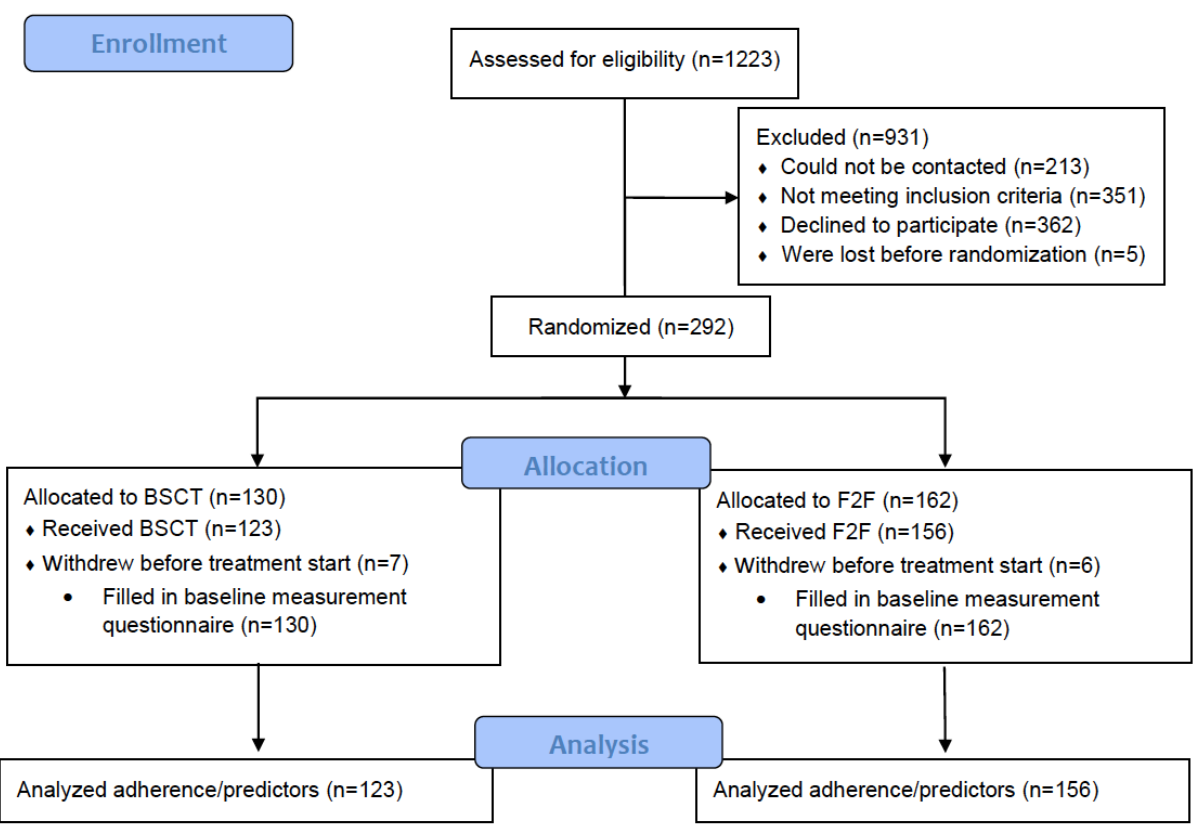
Figure 1. Flow of participants through the study. BSCT: blended smoking cessation treatment; F2F: